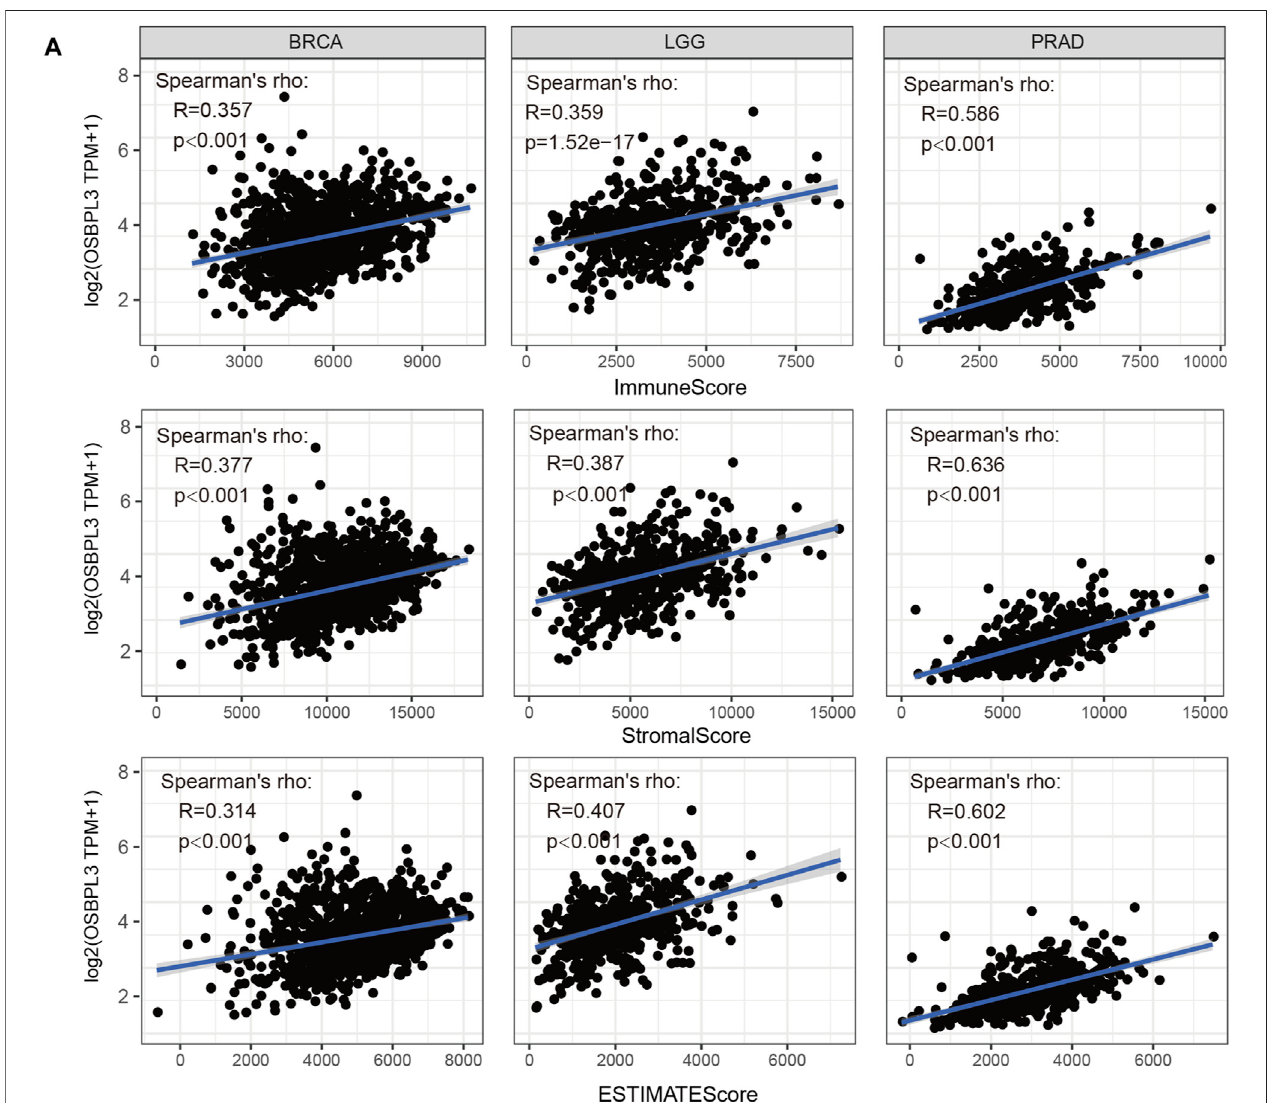
FIGURE 8 | Correlation analysis between OSBPL3 expression and immune in fi ltration score in different tumors. We estimated the immune cells, stromal cells, and tumor purity in the tumor microenvironment based on the ESTIMATE algorithm for “ Est_ImmuneScore, ” “ ESTIMATEScore, ” and “ StromalScore, ” and we analyzed the relationship between them and the expression level of OSBPL3, respectively, in the top three tumors — breast cancer (BRCA), lung cancer (LGG), and prostate adenocarcinoma (PRAD) — which are most relevant.